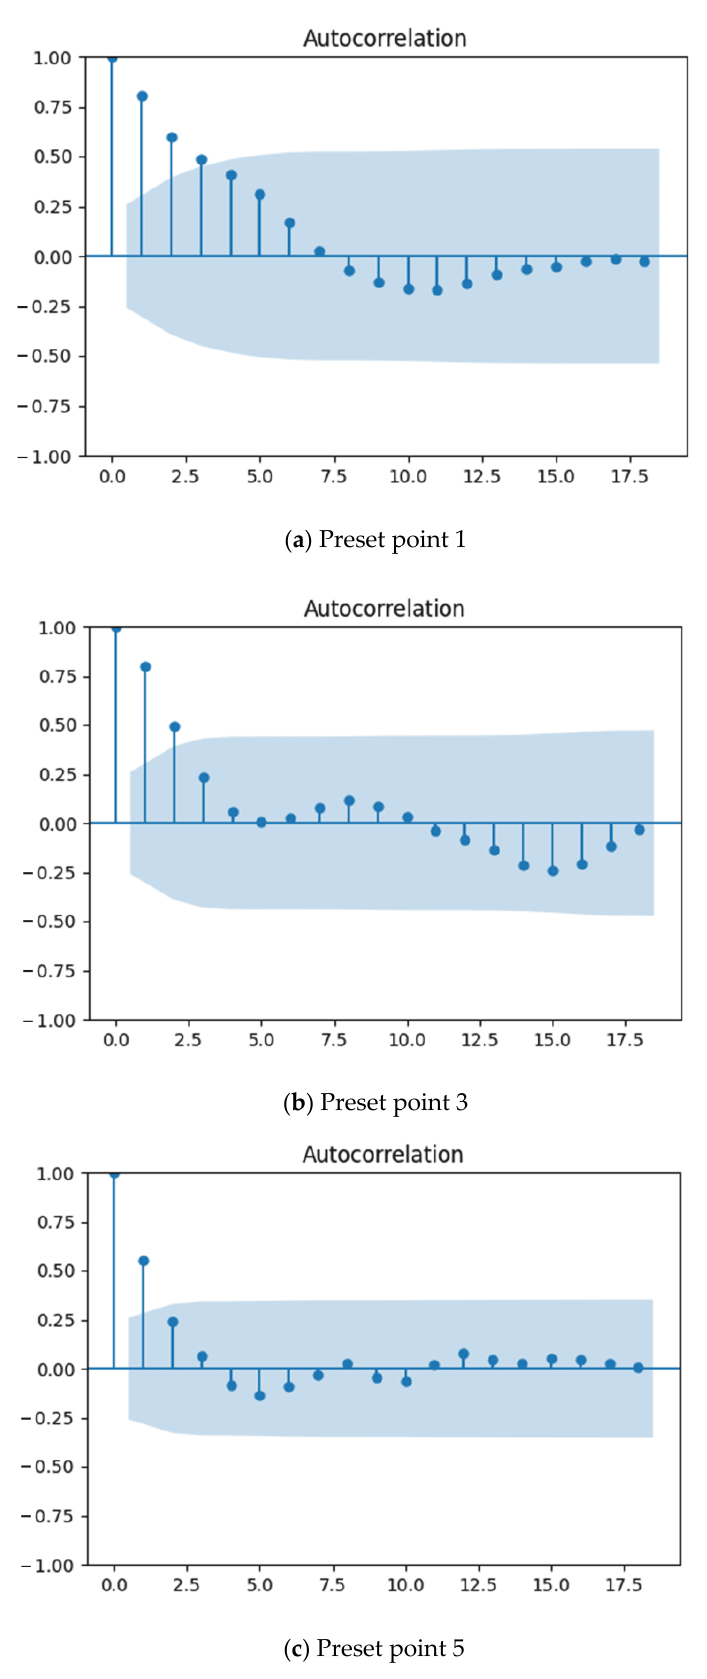
Figure 8. Autocorrelation plot of the GRU model.